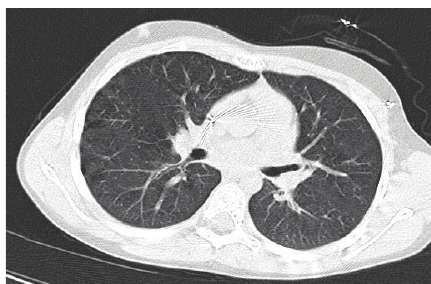
Figure 1: CT scan of the chest prior to start of HSCT. This showed no lung abnormality.